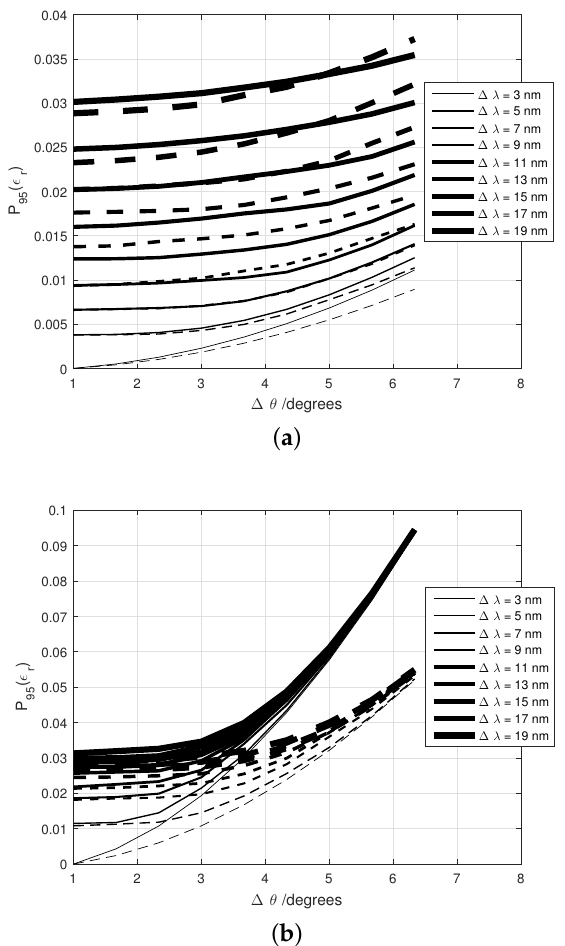
Figure 5. Spectral-BRDF-error descriptors, P 95 ( (cid:101) r ) , obtained in this study for ( a ) Interference-based special effect coatings (Colorstream R (cid:13) T20-04 WNT Lapis Sunlight (solid line) and Colorstream R (cid:13) T20-02 WNT Arctic Fire (dash line)) ( b ) Diffraction-based special effect coatings (SpectraFlair R (cid:13) Silver 1500-35 (solid line) and SpectraFlair R (cid:13) Plus 25 (dash line)). Two highly goniochromatic coatings of each type are represented, identified by solid and dashed